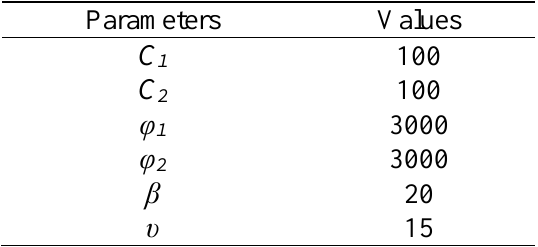
Table 1. Initial values of input